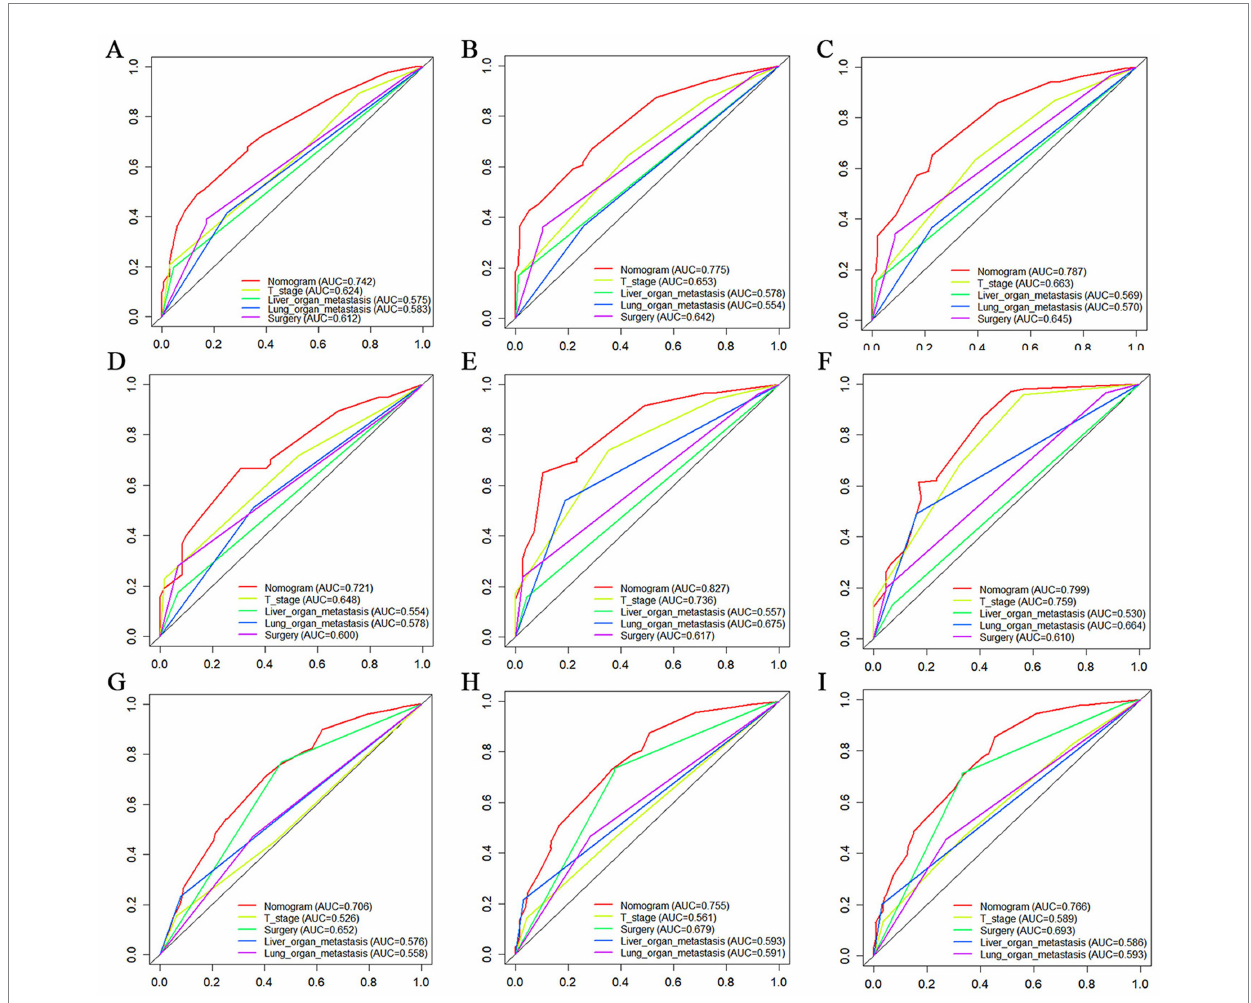
FIGURE 10 The Comparative Receiver operating characteristic (ROC) for nomogram and single independent prognostic factors at 12 months, 24 months and 36 months in the training set (A–C) , validation set (D–F) and extended validation set (G–I)